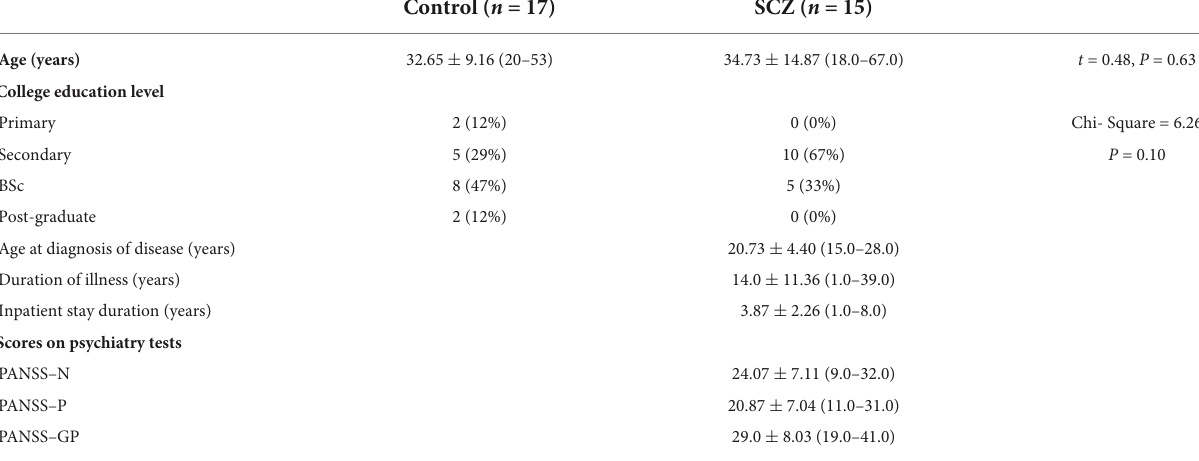
TABLE 1 Demographic characteristics for all participants, with clinical characteristics for the SCZ.